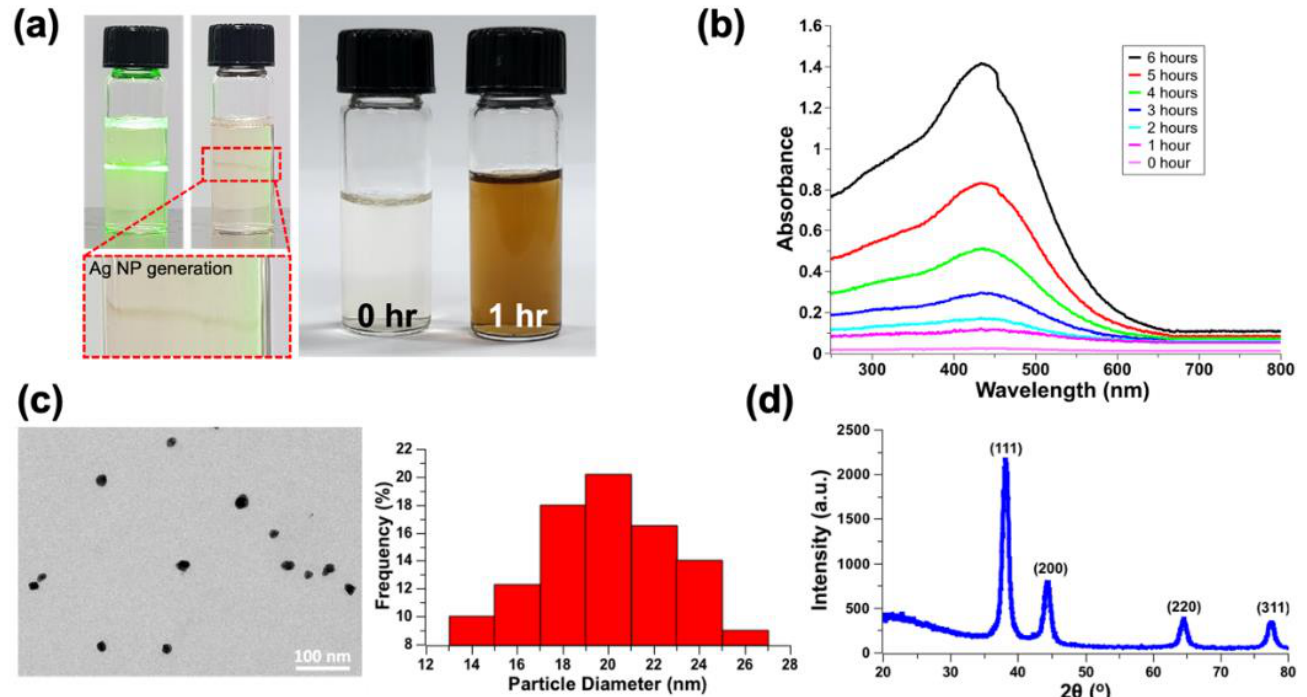
Figure 3. Characterization of precursor. ( a ) Generation of silver nanoparticles by laser irradiation, ( b ) absorption spectra of precursor for silver nanoparticle generation, ( c ) TEM image and particle size distribution, and ( d ) result of high-resolution X-ray diffraction (HR-XRD).